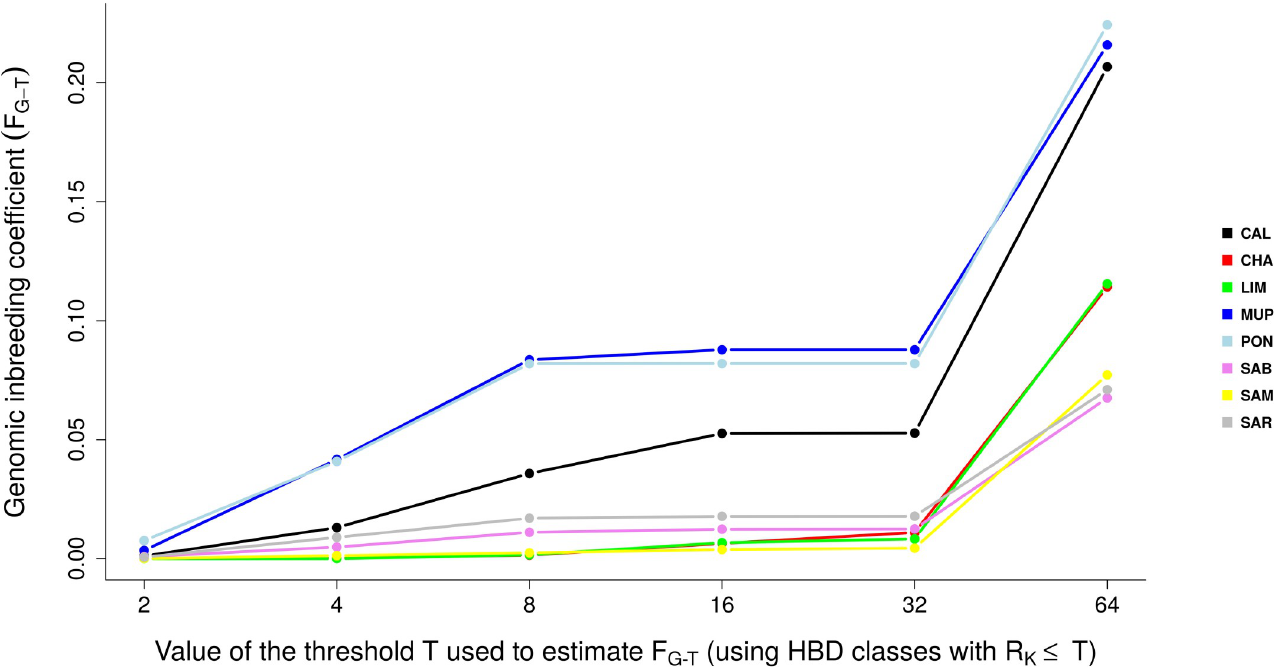
Fig 9. Genomic inbreeding coefficients estimated respect to different base populations (F G-T ) selecting different thresholds T, setting the base population approximately 0.5 � T generations ago.